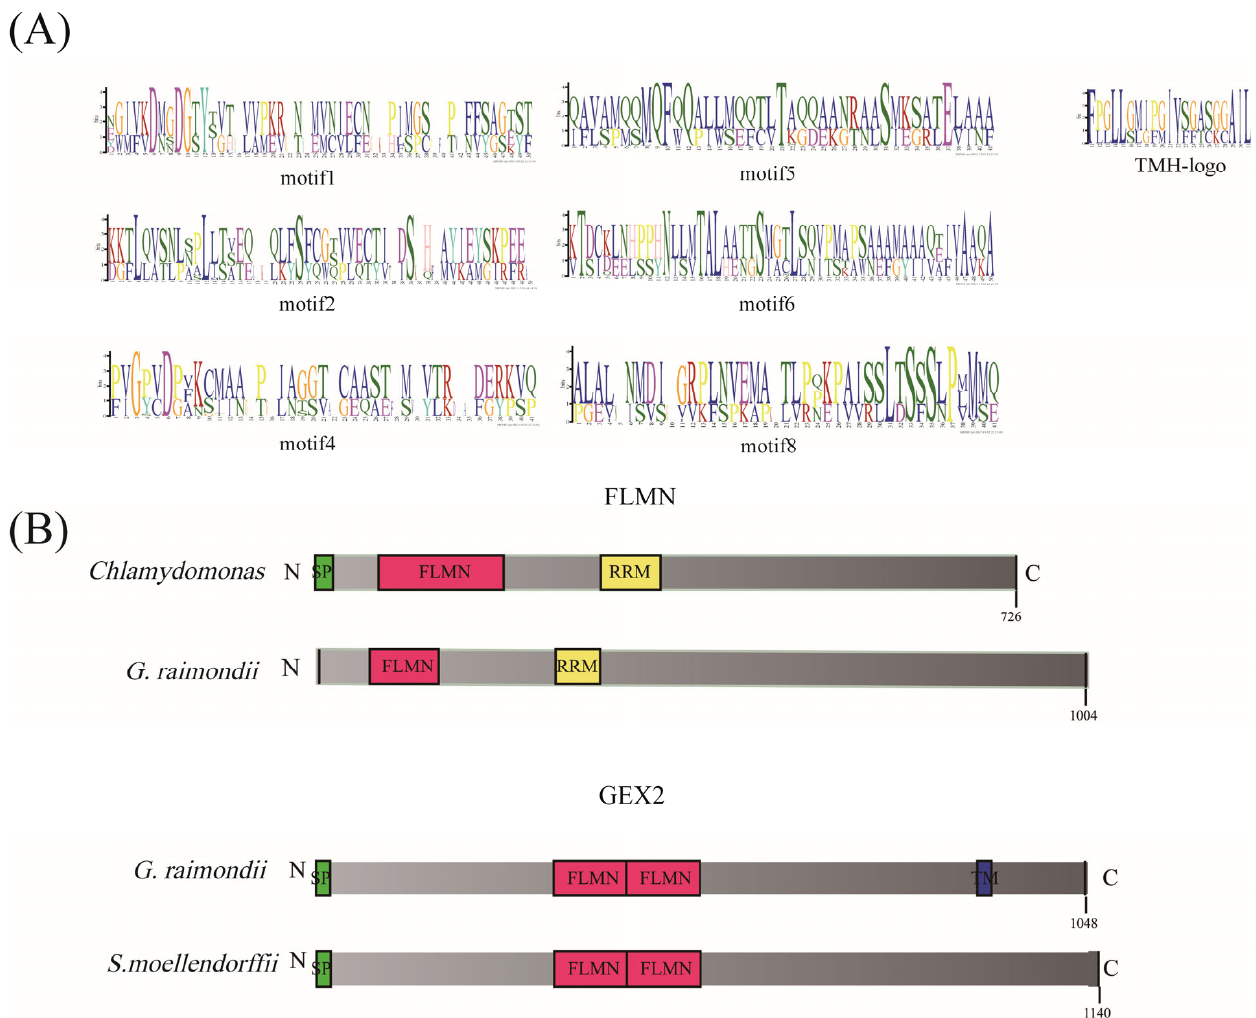
Figure 5. ( A ) Sequence logos of conserved motifs (Motif1, Motif2, Motif4, Motif5, Motif6 and TMH-logo); ( B ) domain arrangement model of filamin proteins’ domain in space. SP stands for signal peptide, TM stands for transmembrane region.